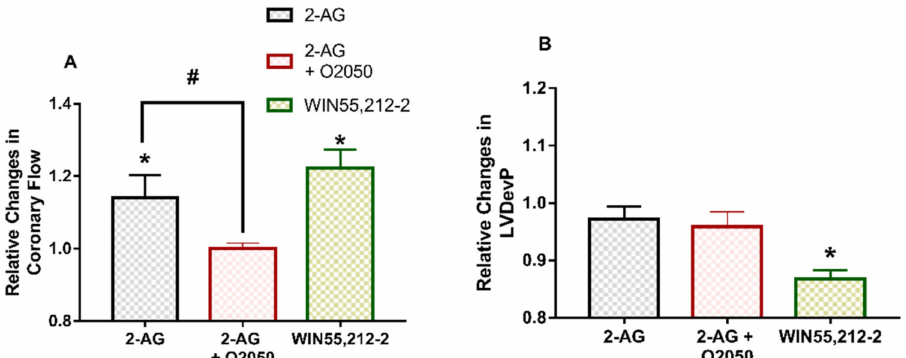
Figure 4. Peak effects of 2-arachydonoyl-glycerol (2-AG) and synthetic CB receptor agonist WIN55,212-2 on coronary flow ( A ) and left ventricular developed pressure (LVDevP) ( B ) of isolated rat hearts. 2-AG (10 − 6 M) and WIN55,212-2 (10 − 6 M) were administered to the perfusate for 5 min. After a 10-min wash-out period, the 2-AG infusion was repeated in the presence of CB 1 R antagonist O2050 (10 − 6 M). Data are presented as relative values compared to pre-infusion control data. Mean ± SEM; n = 9 (2-AG and 2-AG + O2050 experiments) and n = 5 (WIN55,212-2 experiments); * p < 0.05 vs. pre-infusion value; # p < 0.05 vs. 2-AG peak effect, paired t